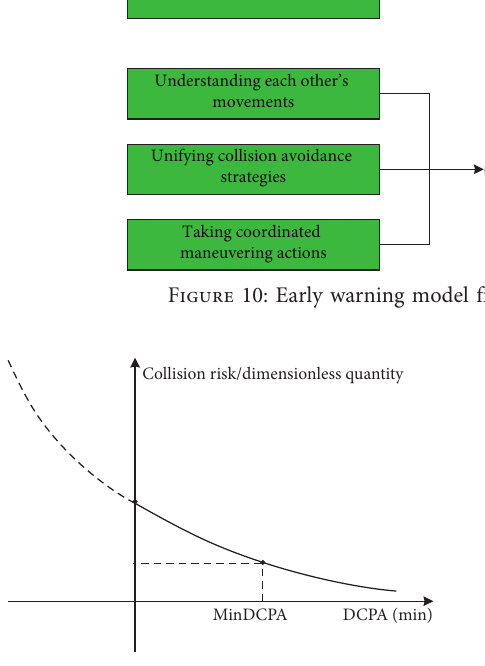
Figure 11: Relationship between DCPA and collision risk.